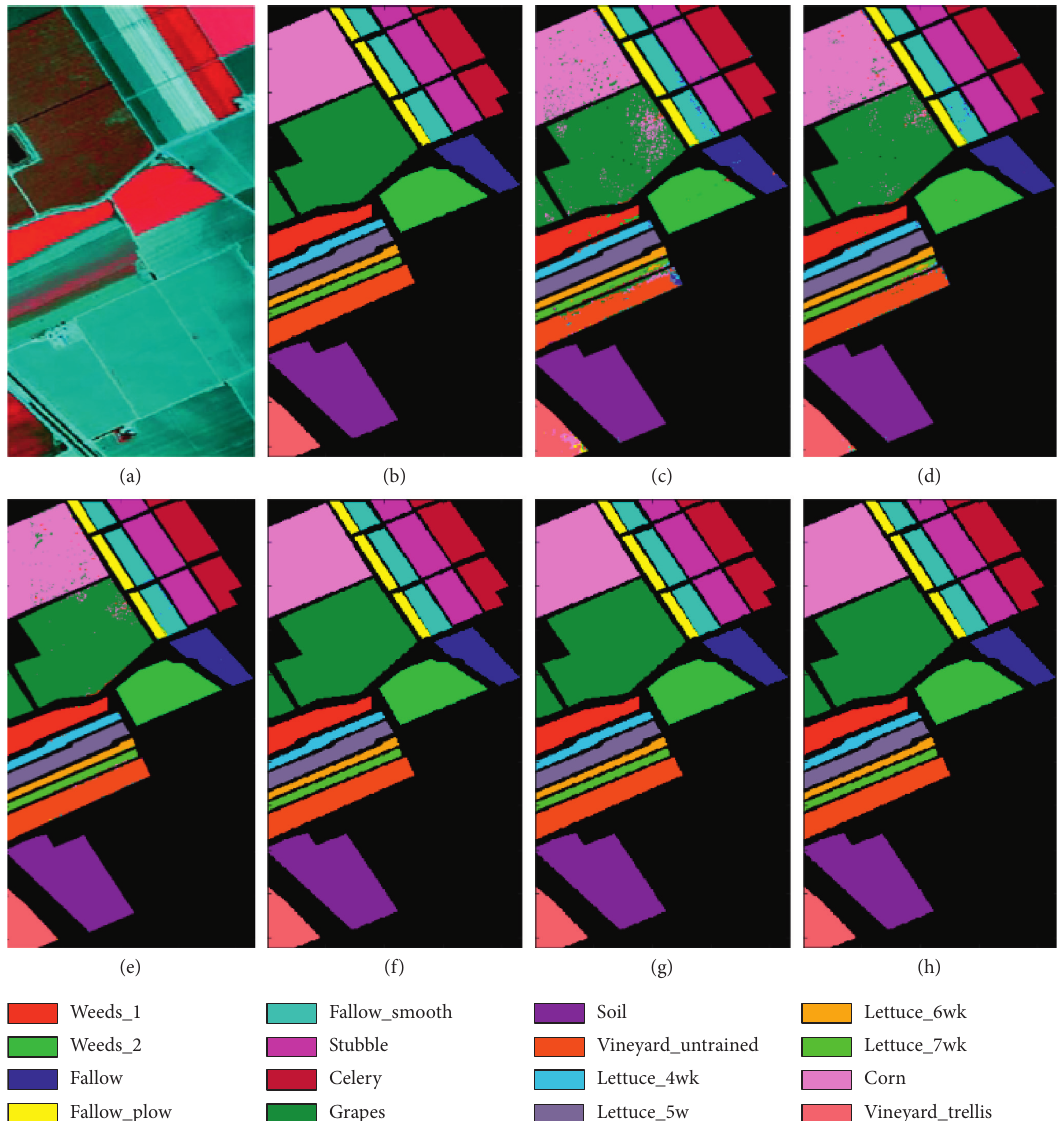
Figure 14: Classification maps for the SA dataset. (a) False color image, (b) ground truth, and (c)-(h) classification maps for SVM-RBF, 2D CNN, 3D CNN, SSRN, HybridSN, and proposed